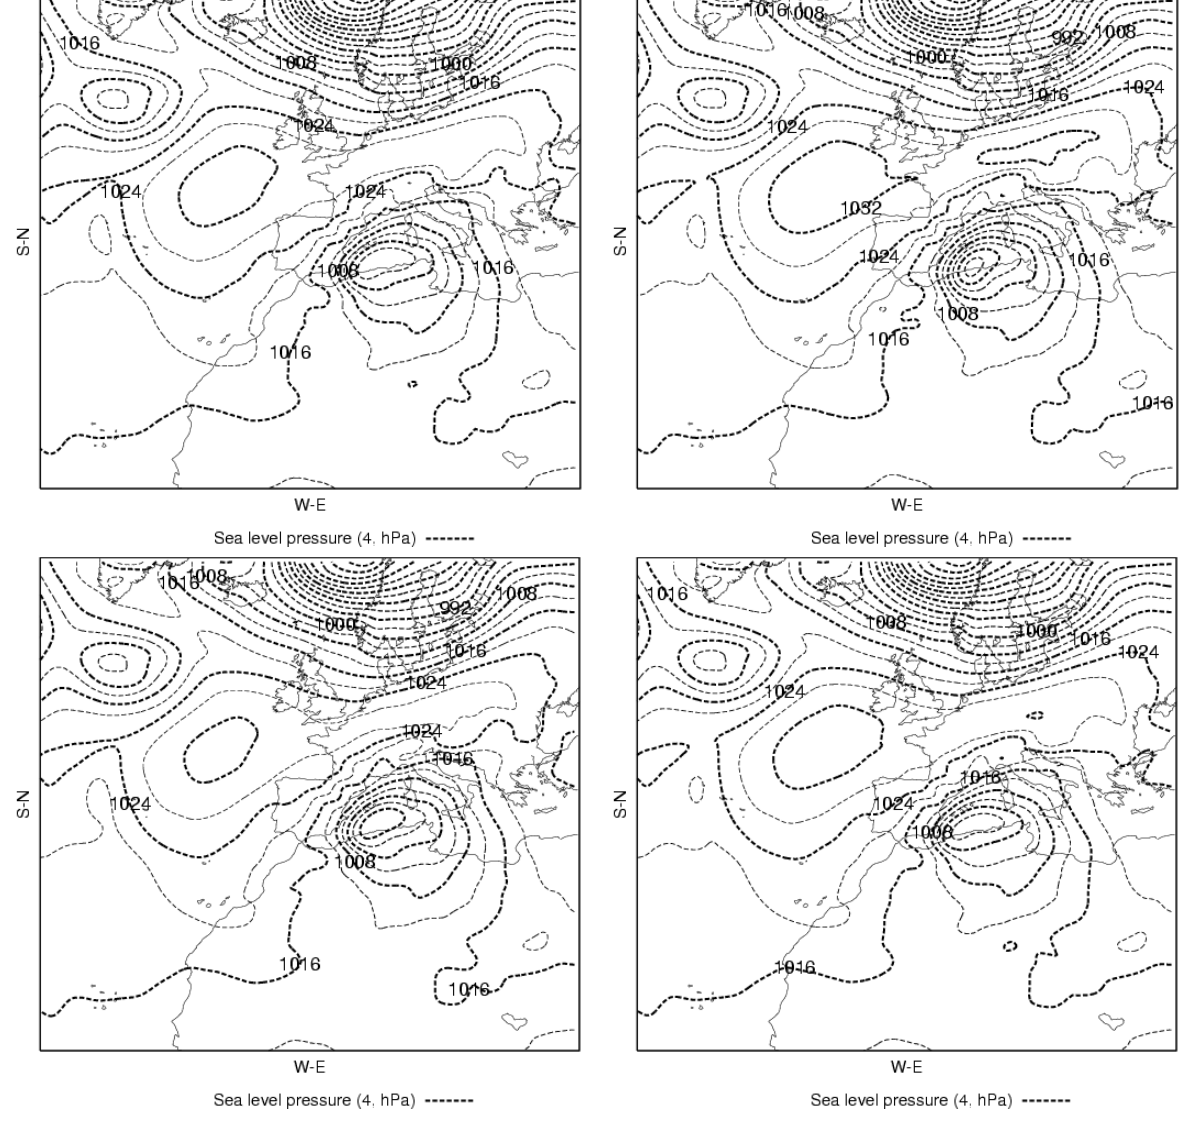
Fig. 10. Sea level pressure at the mature state of the cyclone (11 November 00:00UTC). Lines every 2hPa. For the control simulation (top left), +ErPVpTerm (top right), +ErPVp01 (bottom left) and +ErPVpHigh (bottom